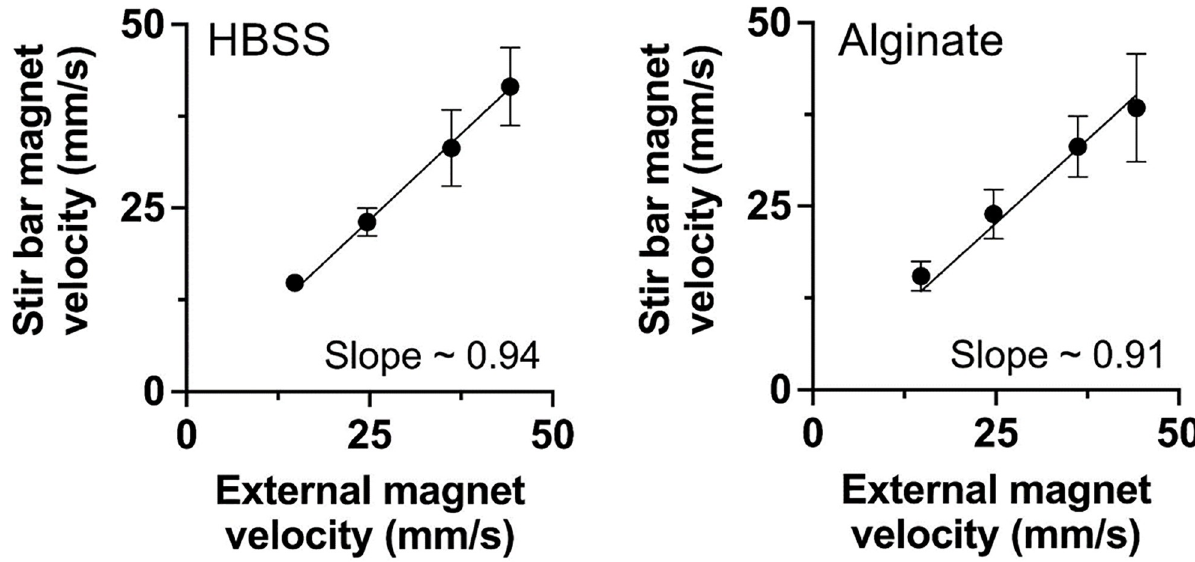
Fig 2. Stir bar velocity in a syringe can be externally controlled. The velocity of the stir bar in HBSS (left) or 1% w/v alginate (right) solution was measured with varied external magnet velocity. Best fit lines were plotted using linear regression with y-intercept = 0 (R 2 > 0.96). All data are from n = 3 independent experiments. Error bars indicate standard